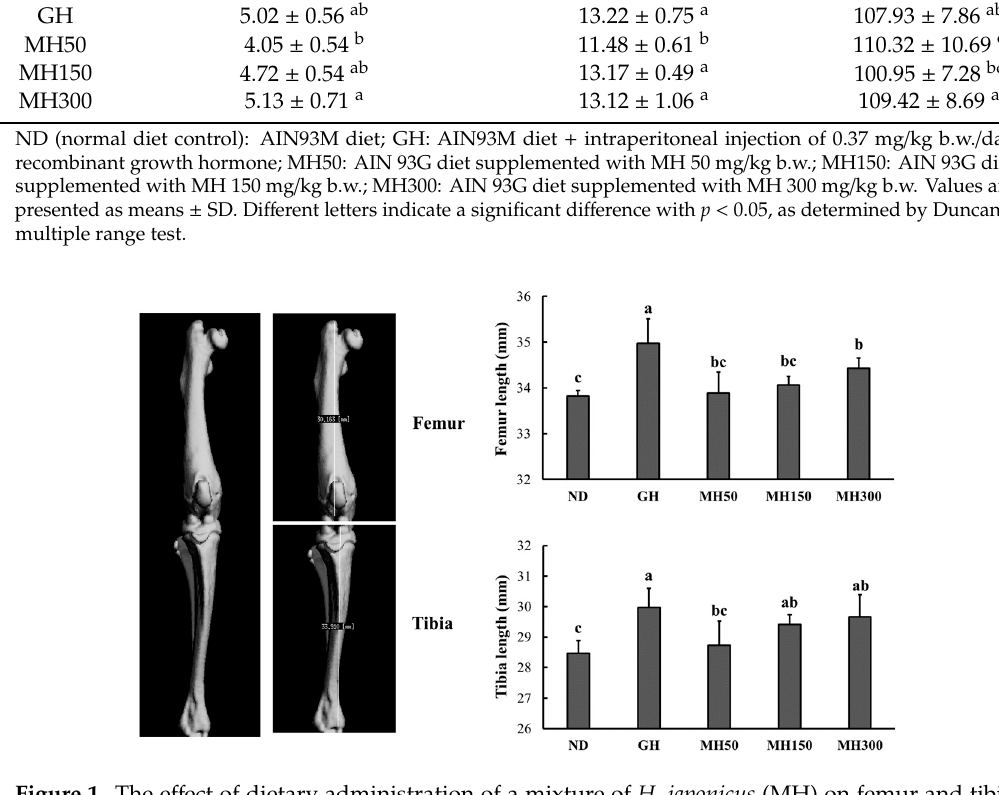
Figure 1. The e ff ect of dietary administration of a mixture of H. japonicus (MH) on femur and tibia lengths in SD rats. ND (normal diet control): AIN93M diet; growth hormone (GH): AIN93M diet